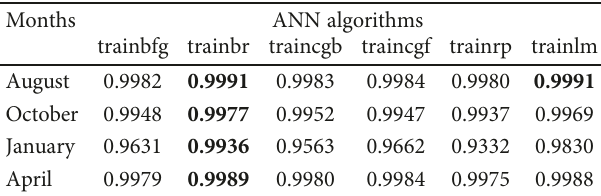
Table 3: ANN algorithm estimation results in